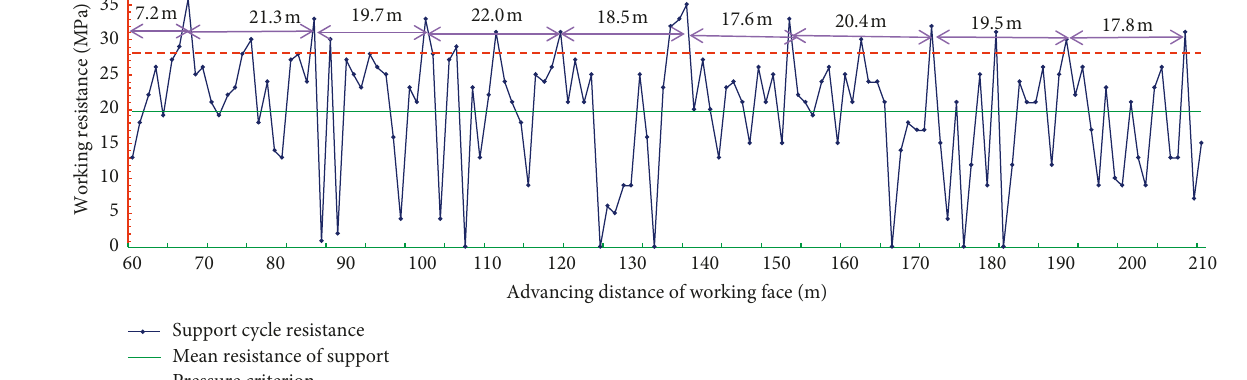
Figure 9: Support resistance change curves during the advancing of the backfilling face.